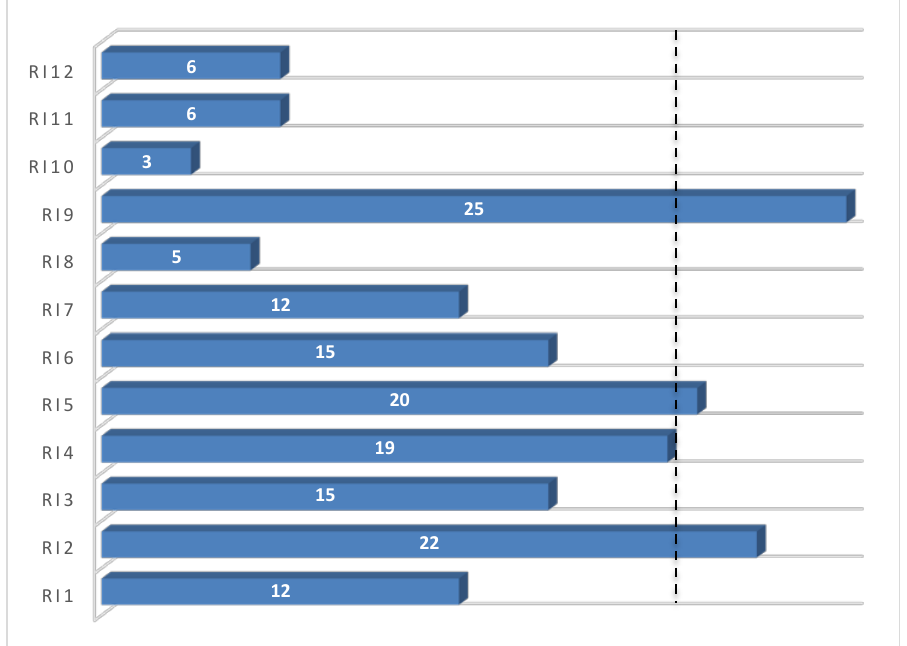
FIGURE 2: Current practices in disclosure in risk identification and mitigation